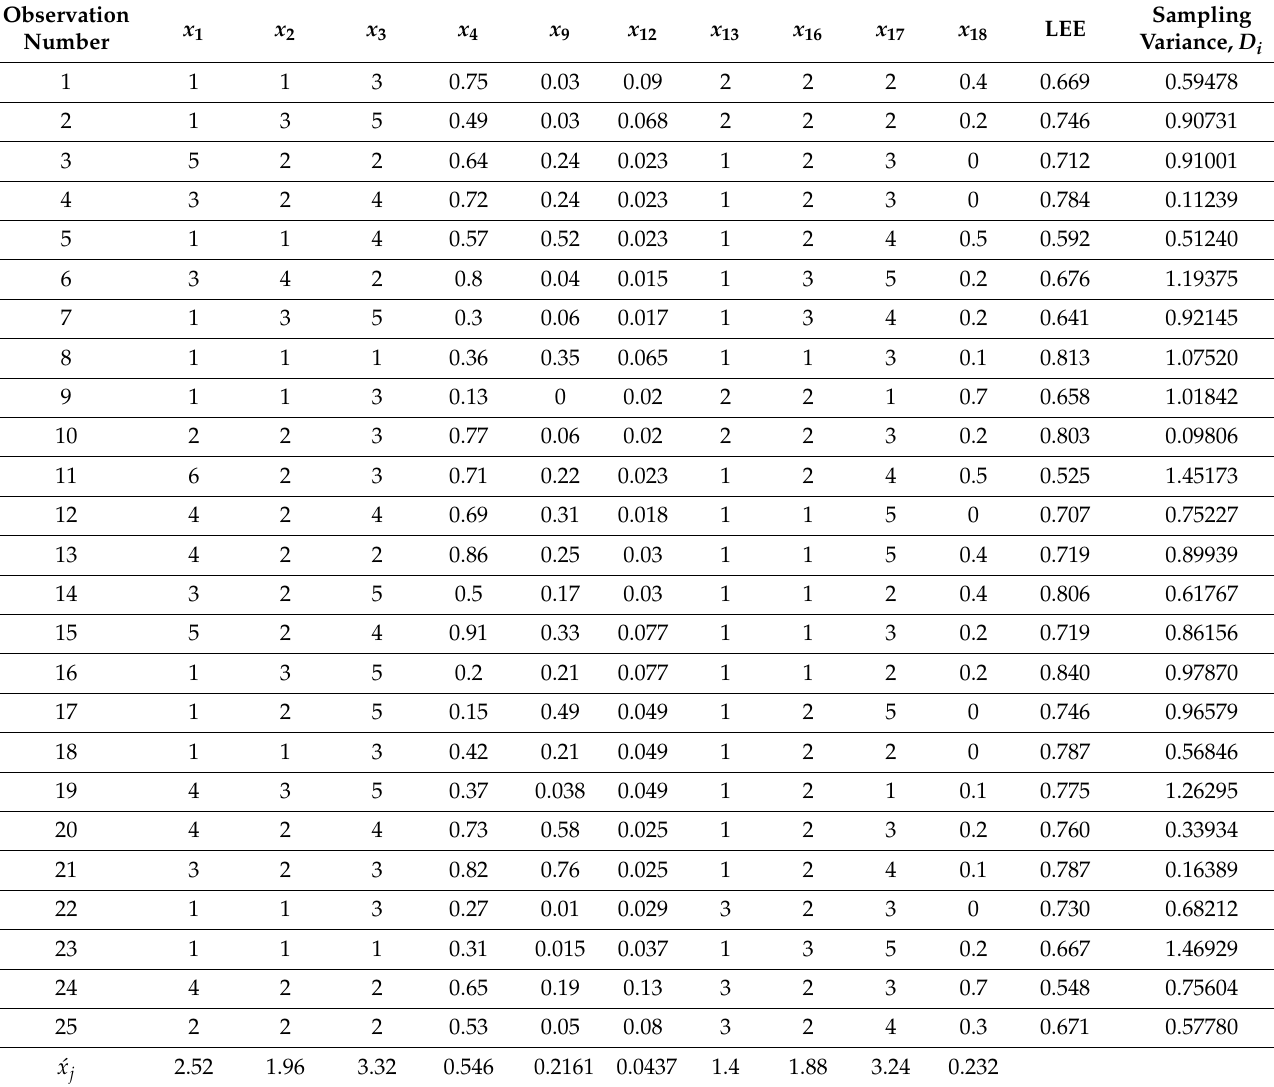
Table 7. Values of basic and resulting parameters of the TrEECS